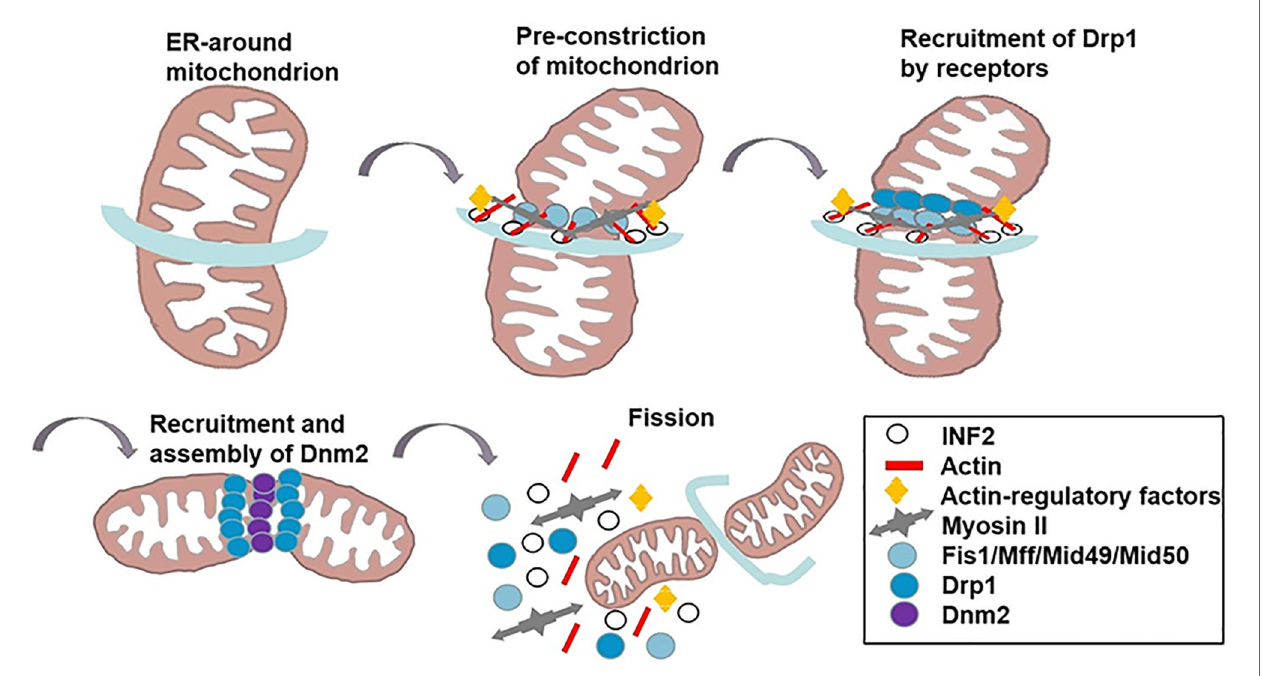
FIGURE 1 | The mechanism of mitochondrial fi ssion. INF2 causes the polymerization of actin at the ER-mitochondrial contact point to generate forces that drive ER tubules around the mitochondria and reduce mitochondrial. Actin-regulatory factors induce actin fi lament nonequilibrium assembly. Myosin II is recruited to the fi ssion site, causing mitochondrion shrinkage. Subsequently, DRP1 is recruited to the marked division sites to bind to its OMM receptors (Fis 1, Mff, MiD49/51). DNM2 assembles in the DRP1-regulated mitochondrial constriction neck to push mitochondrial scission. GTP hydrolysis results in conformational changes which further augment membrane contraction. Finally, mitochondrion splits to two daughter mitochondria, and the fi ssion complex are